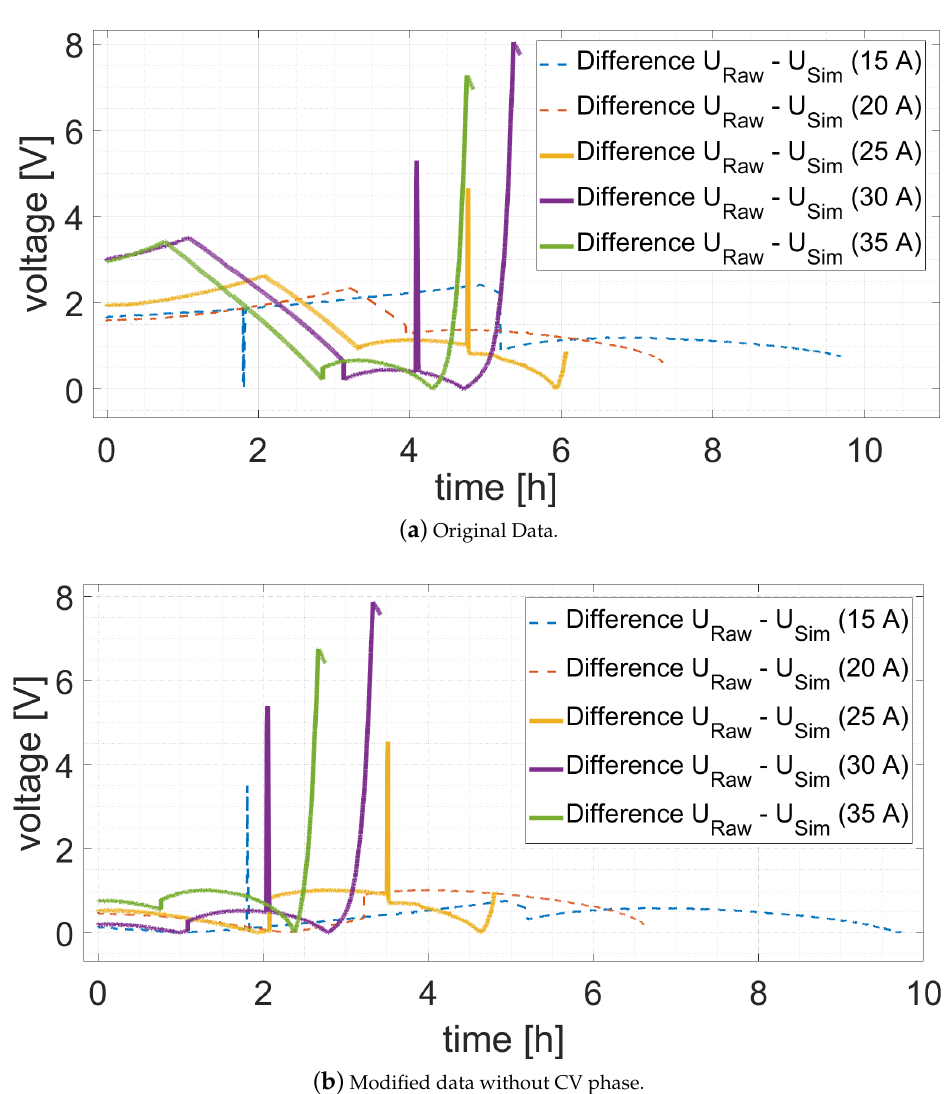
Figure 11. Error deviation from the simulation model to the raw data with the: ( a ) original data; ( b ) modified data without CV